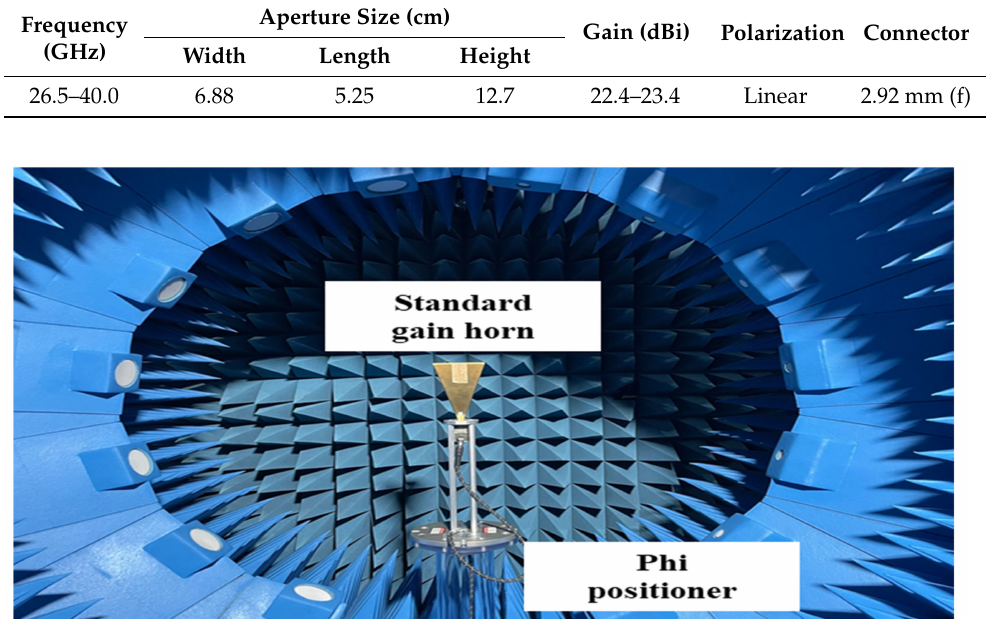
Table 2. Intercomparison Antenna Specifications.